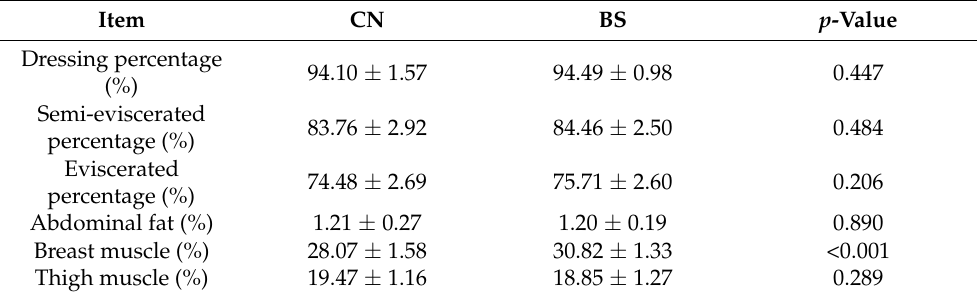
Table 3. Effects of dietary Brevibacillus laterosporus S62-9 on the carcass traits of chicken